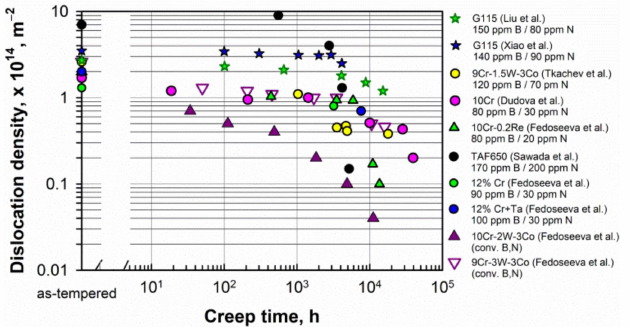
Figure 20. Evolution of the dislocation density during creep in the 9–12% Cr steels. Data from